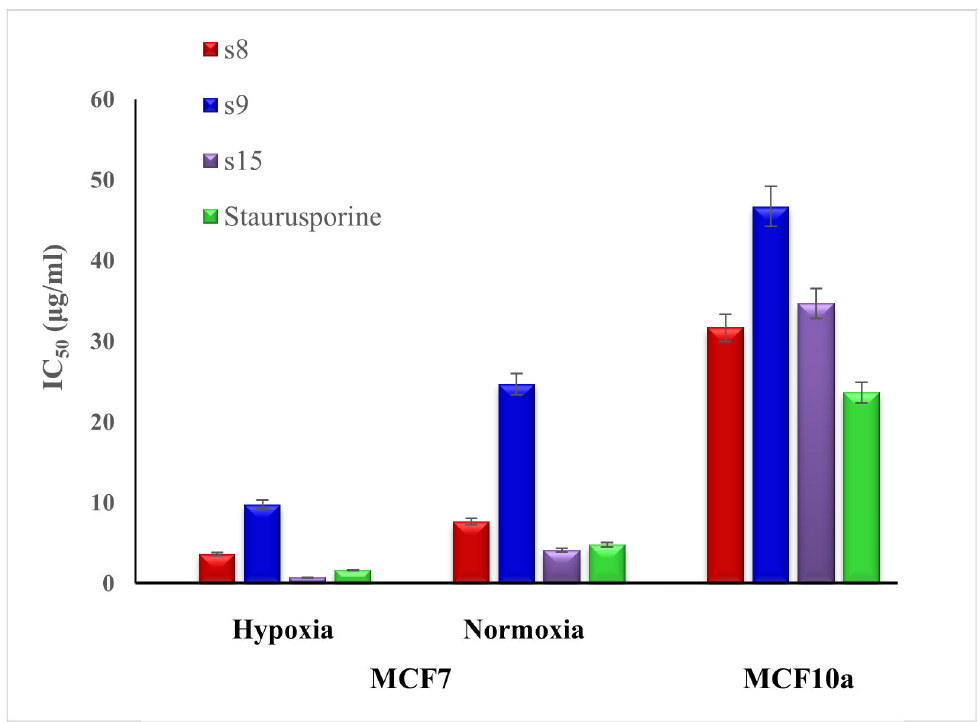
Figure 4. Effect of S8 , S9 and S15 compounds on cell viability of MCF7 (normoxia and hypoxia) and MCF10a cells using Staurosporine as reference standard. Data expressed as mean ± SEM.